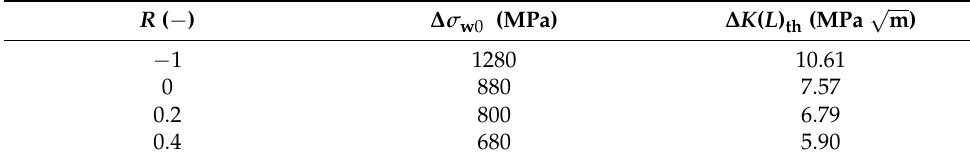
Table 3. ∆ σ w0 and ∆ K ( L )